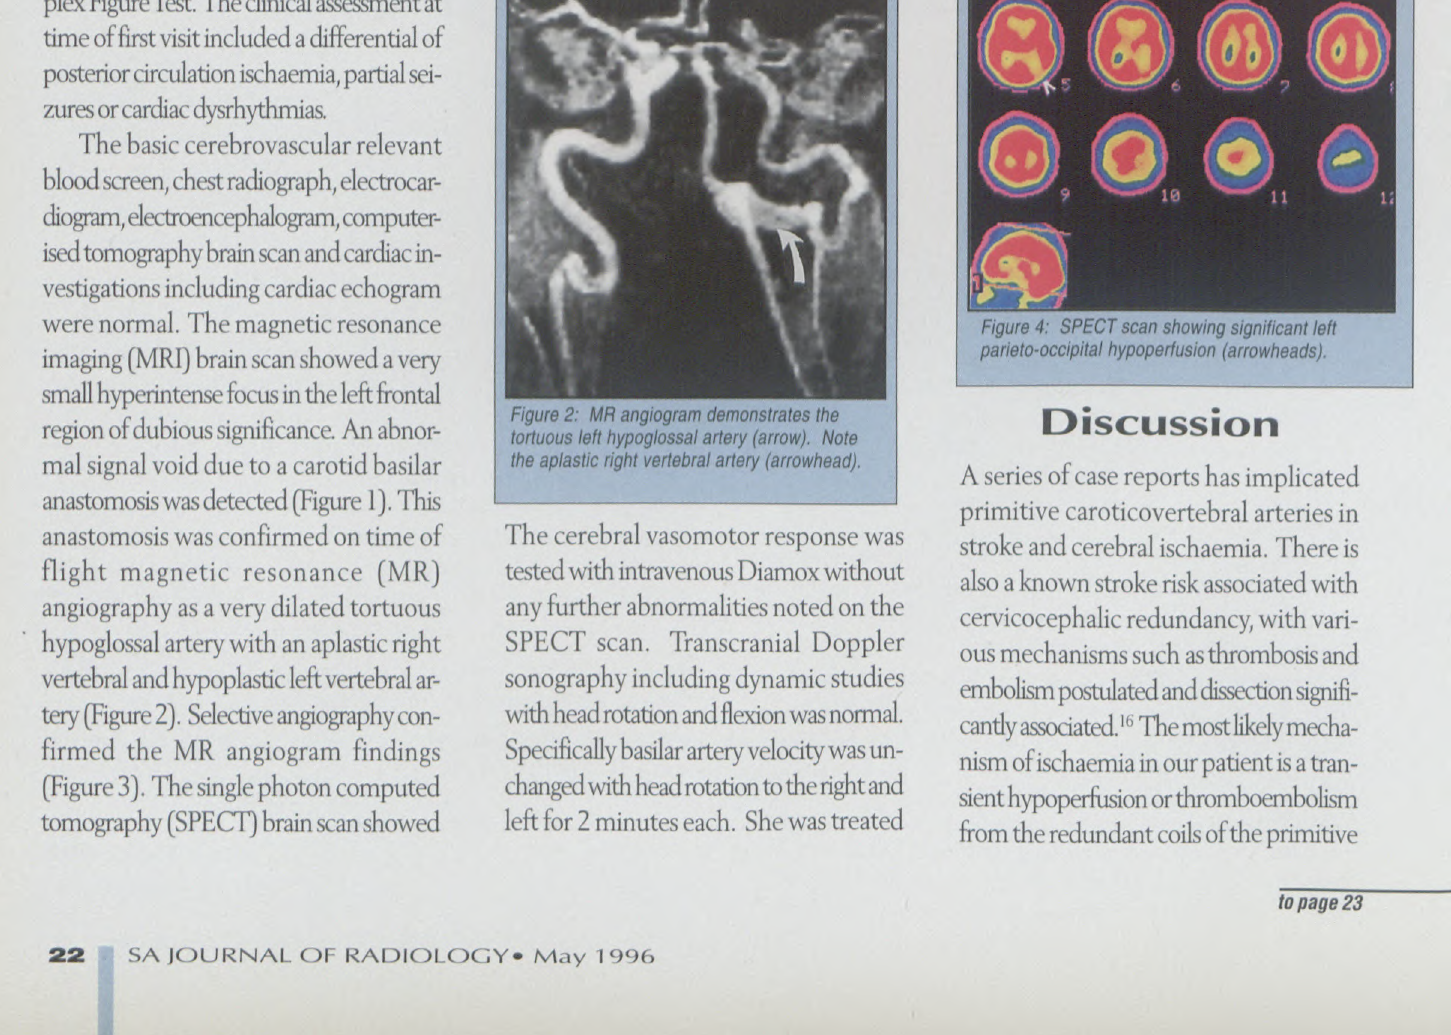
Figure 3: Selective left vertebral angiogram confirms the tortuous left hypoglossal arterial anastomosis